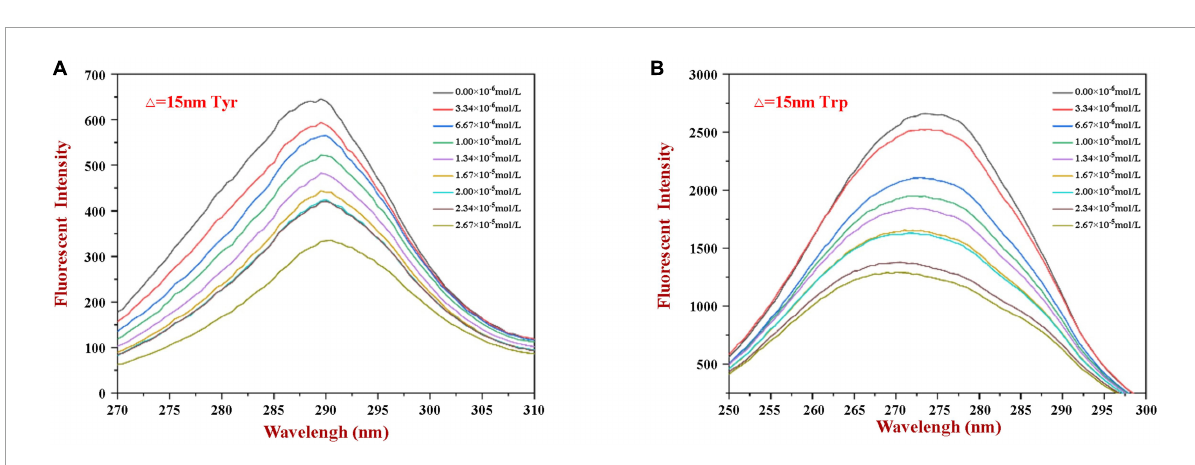
FIGURE3 The synchronous fluorescence spectrum of WP in the absence and presence of HES at (cid:49) λ = 15 nm (A) and (cid:49) λ = 60 nm (B) .